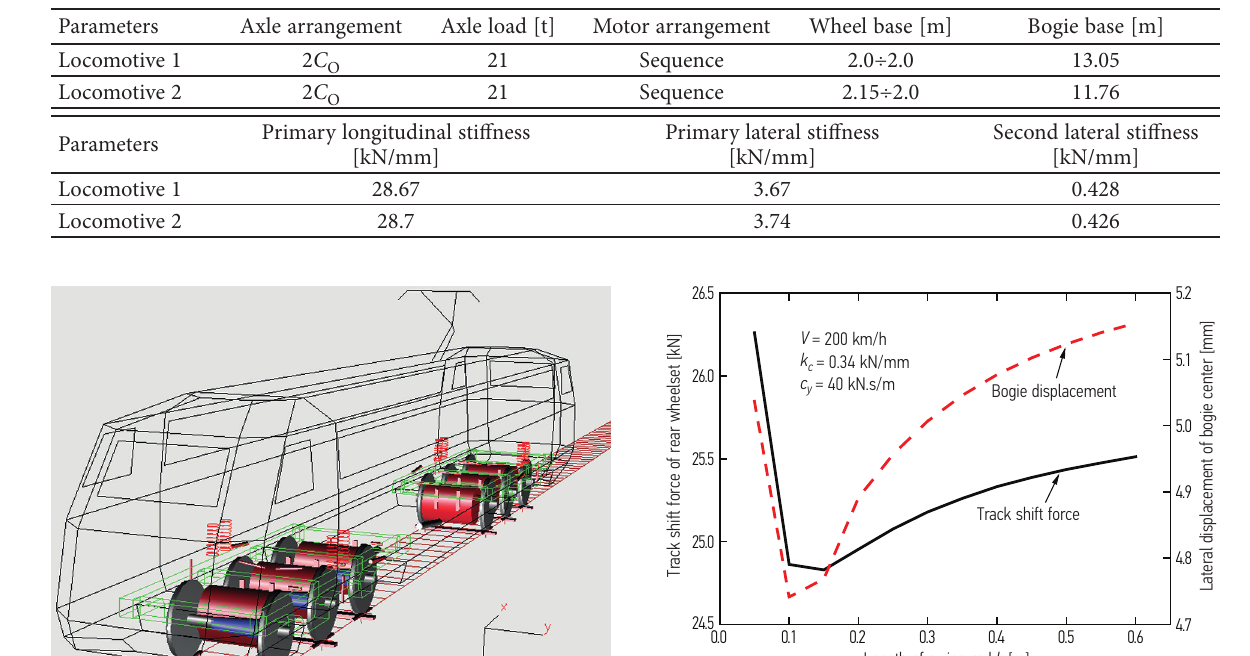
Table 3. The main parameters of locomotives